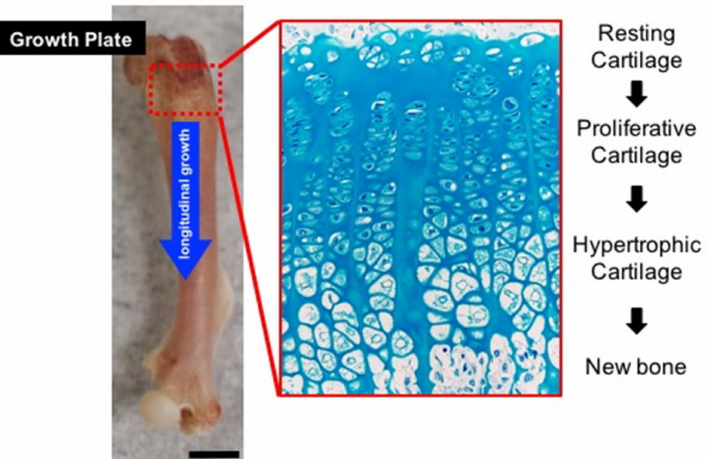
Figure 1. The longitudinal growth of long bone by the growth plate. The growth plate is composed of highly organized and specialized three types of cartilage: the resting, proliferative, and hypertrophic zone. Resting zone chondrocytes supply stem-like cells that give rise to clones of proliferative zone chondrocytes, and determine the spatial orientation of adjacent proliferative columns parallel to the long axis of the bone. The proliferative zone is the region of active cell replication. Hypertrophic zone chondrocytes provide a cartilaginous template, mineralized by their extracellular matrix, supporting the new bone formation by osteoblastic cells. Scale bars indicate 1.25